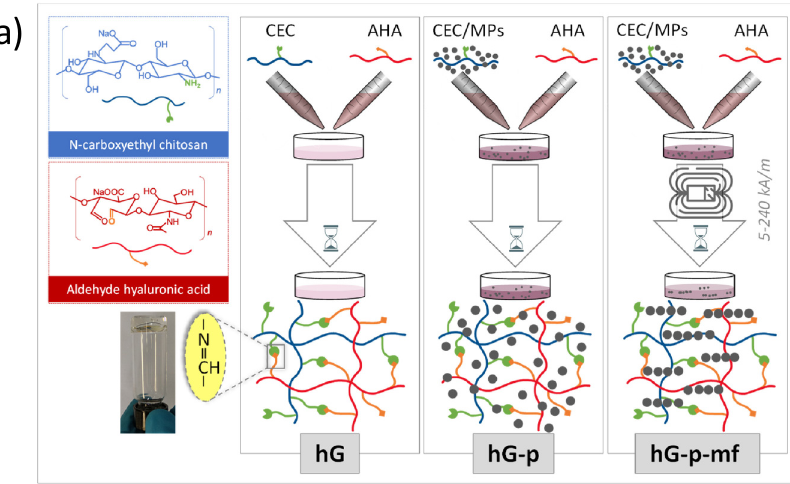
b) Figure 8. Cont